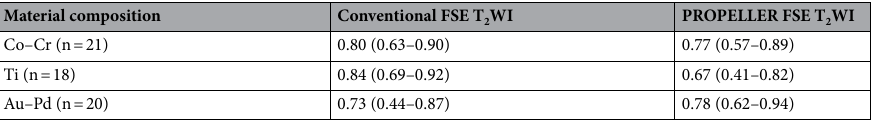
Comparison of artifacts between conventional FSE T different material compositions. Artifacts caused by three different PFM crowns can be clearly identi- fied on both conventional FSE T 2 WI and PROPELLER FSE T 2 WI (Fig. 1). The image quality of Au–Pd was significantly better than those of Ti and Co-Cr in conventional FSE T 2 WI (reader 1 (score ± SD): Au–Pd 3.5 ± 0.1